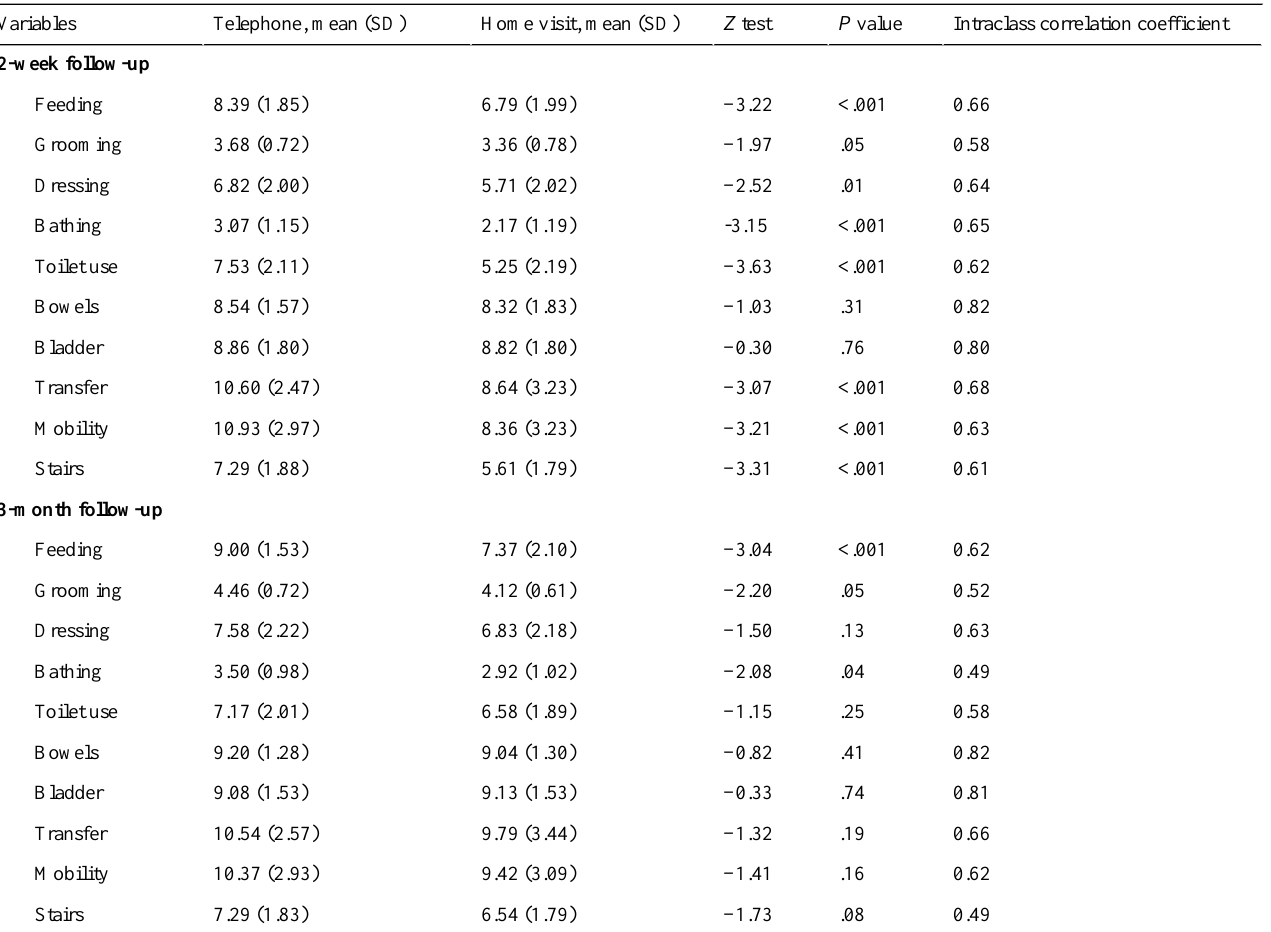
Table 5. Comparison of Modified Barthel Index scores evaluated in telephone and home visit assessments at 2-week follow-up (n=28) and 3-month follow-up (n=24).